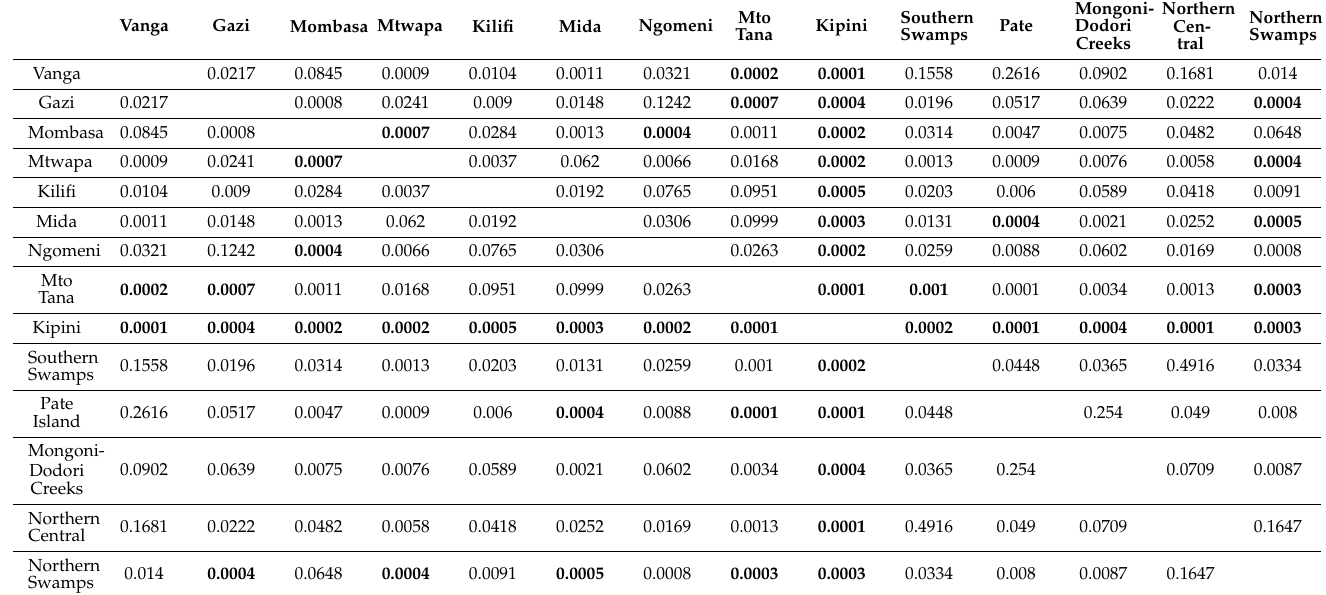
Table A2. Pairwise p value after Bonferroni correction showing the variability in species composition across the 14 sites along the coastline of Kenya as assessed with ANOSIM.